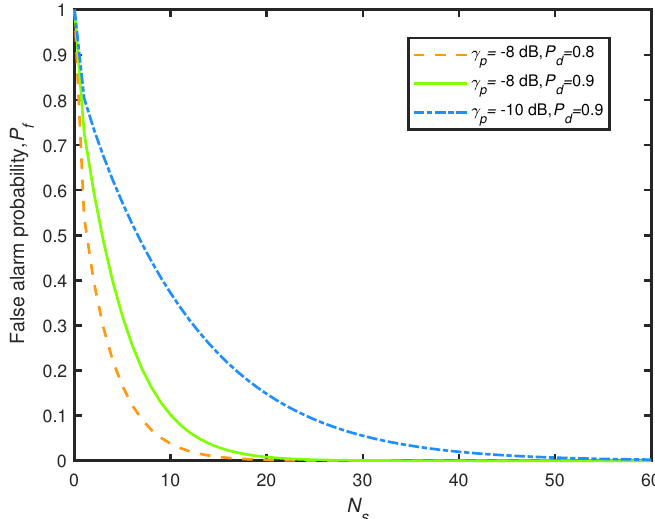
Figure 6. False-alarm probability versus sensing time for different γ p and P d .